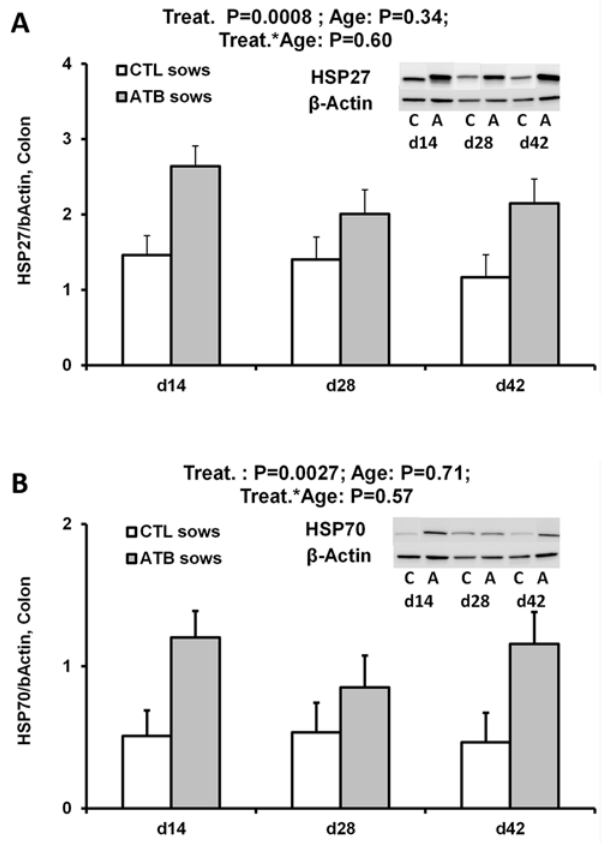
Fig 2. Effects of maternal antibiotic (ATB) treatment on protein expression of inducible heat shock proteins (relative to β -actin) in colonic tissues of offspring between 14 and 42 days of age (weaning at day 28). (LSmeans and SEM, n = 10 – 12 per treatment and age). A. HSP27. Maternal ATB treatment significantly increased offspring colonic HSP27 levels between d14 and d42 of age (P < 0.001). B. HSP70. Maternal ATB treatment significantly increased offspring colonic HSP70 levels between d14 and d42 of age (P < 0.01). Western blot bands from representative pigs are shown for HSP27 and β -actin (A) and for HSP70 and β -actin (B).